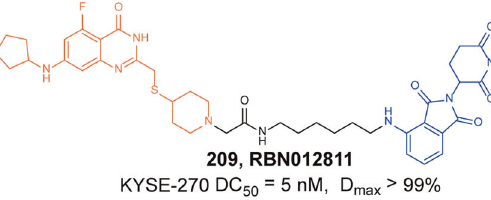
Fig. 62 The representative PROTAC targeting